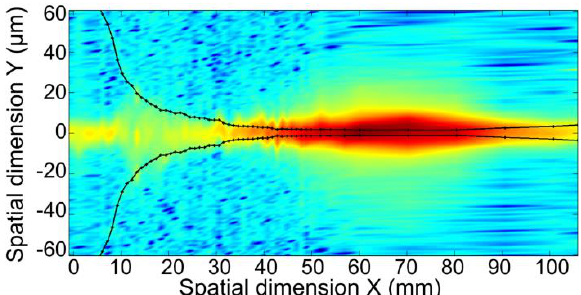
Fig. 3. 2D XY mapping of RS intensity for a single mode fiber @653nm with adiabatic transition (logarithm scale). Black curves correspond to the fiber diameter from CCD camera.